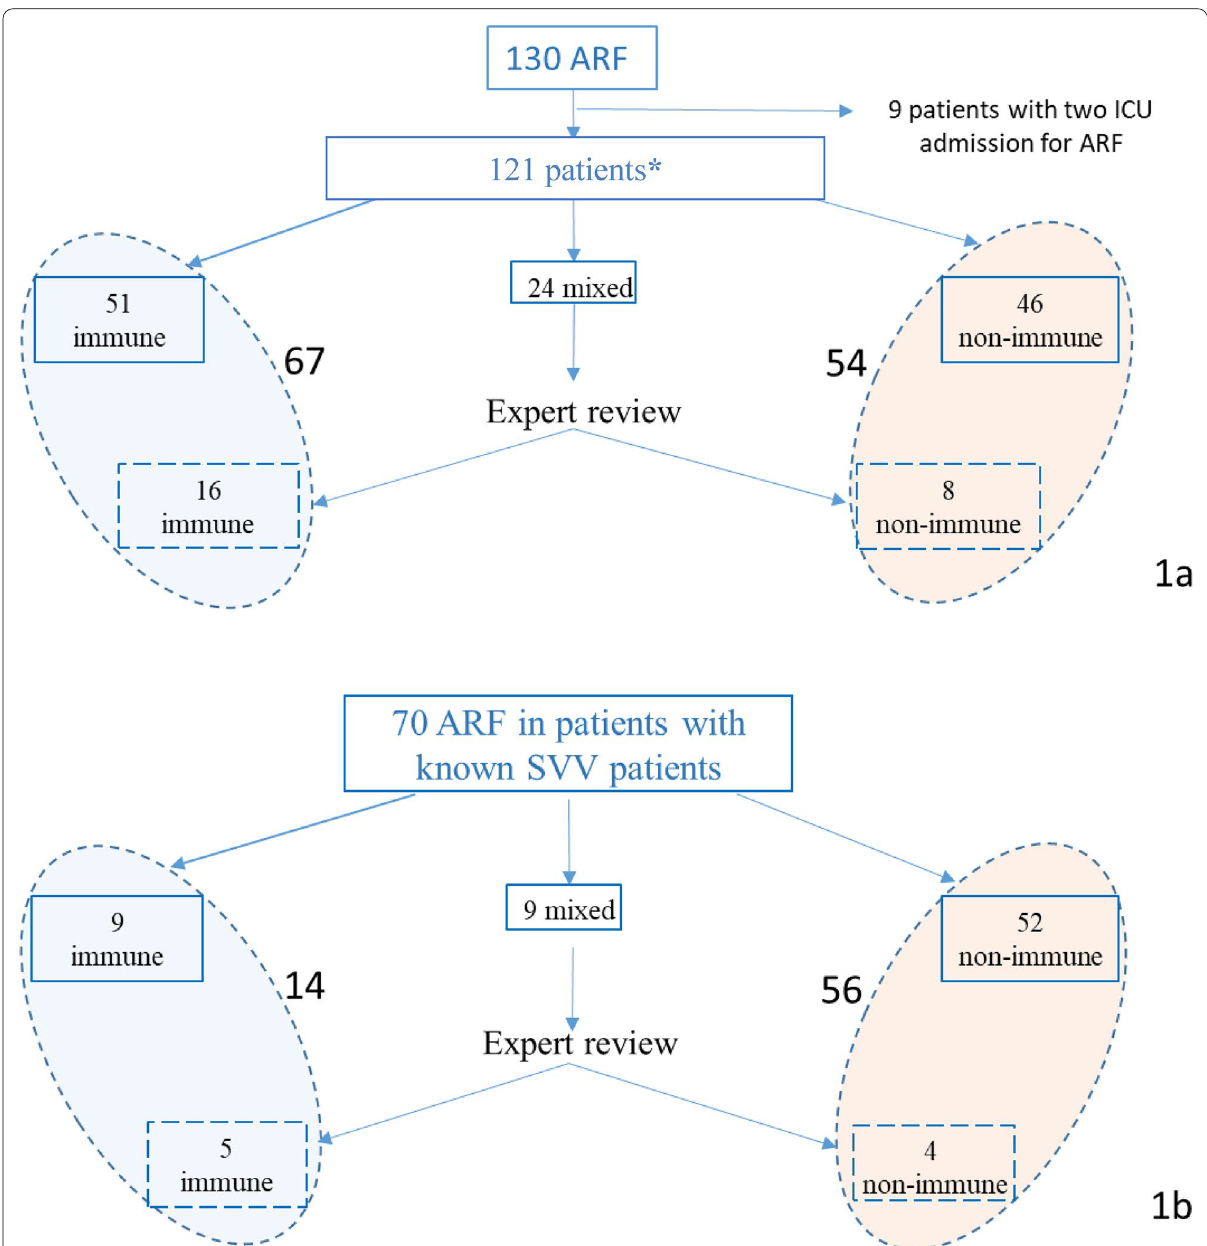
Fig. 1 Flowchart. Classification of the cause(s) of acute respiratory failure (ARF). a Analysis of causes of ARF and of survival ( n admission was considered. b Analysis of risk factors for non‑immune ARF in patients with known Svv ( n considered in the analysis of risk factors for non‑immune ARF in patients with known